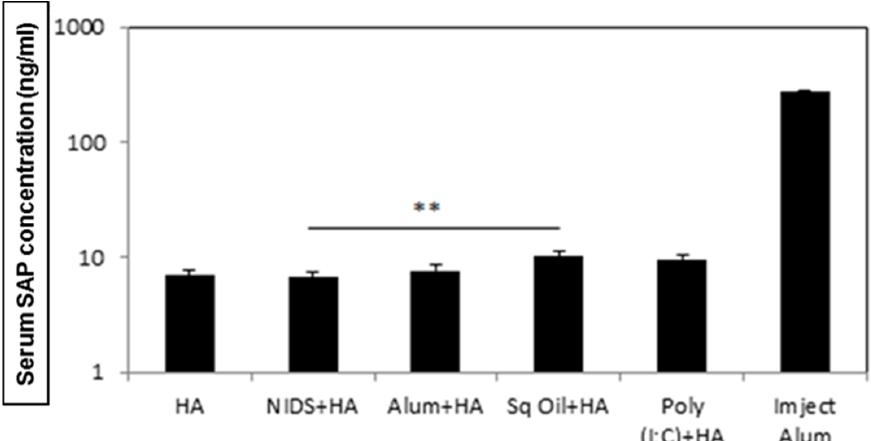
Figure 5. Significantly enhanced Serum Amyloid P component (SAP) concentrations in mice at 16 hours following a single Intra ‐ muscular vaccinations with Sq. oil + HA compared to NIDS + HA or HA alone. The data are presented as mean values from four mice per group ± SEM (error bars). Imject Alum was used as the positive control for the assay. Statistical significance is represented as ** p < 0.01.